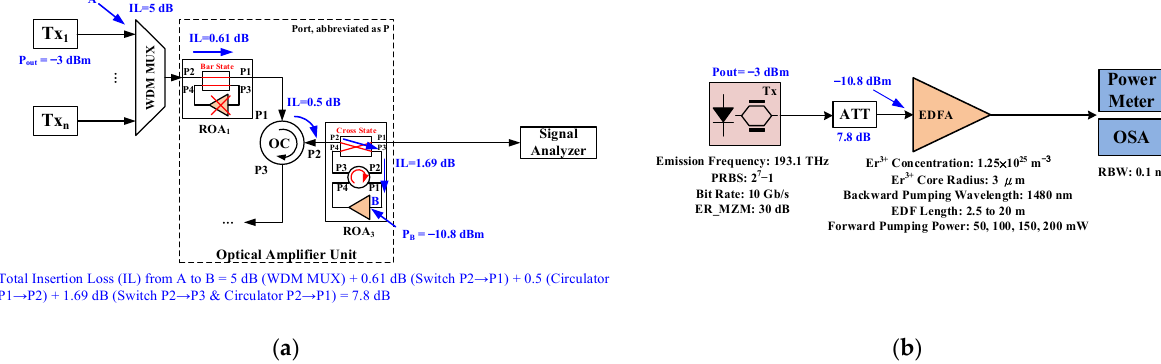
Figure 8. Simulation setup of a backup optical amplifier for ROA 1 : ( a ) detailed setup and ( b ) simpli- fied setup (ATT: attenuator, RBW: resolution bandwidth, OSA: optical spectrum analyzer).